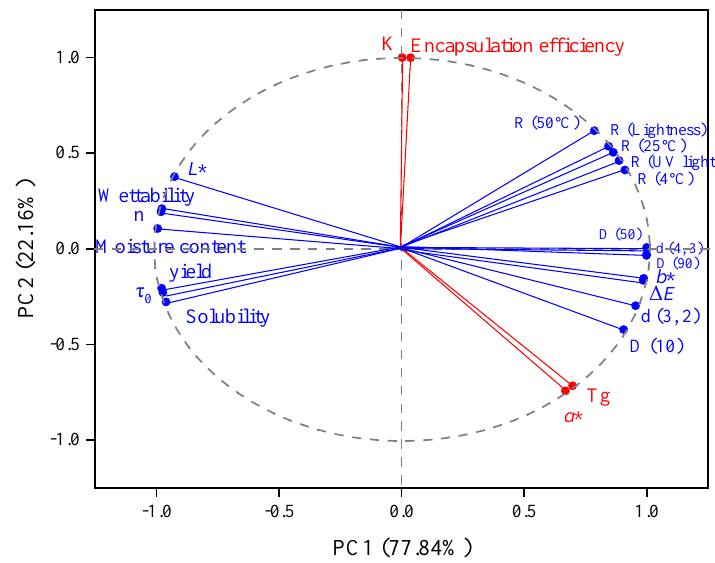
Figure 7. Principal component analysis of group differences.